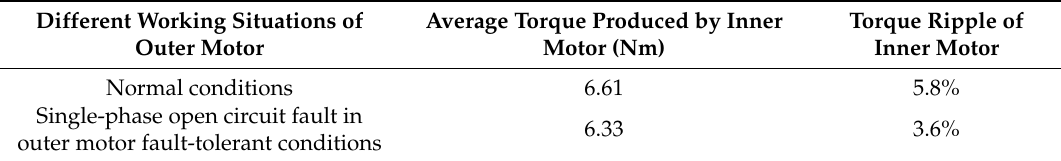
Table 7. The torque (Nm) produced by the inner motor under different conditions.